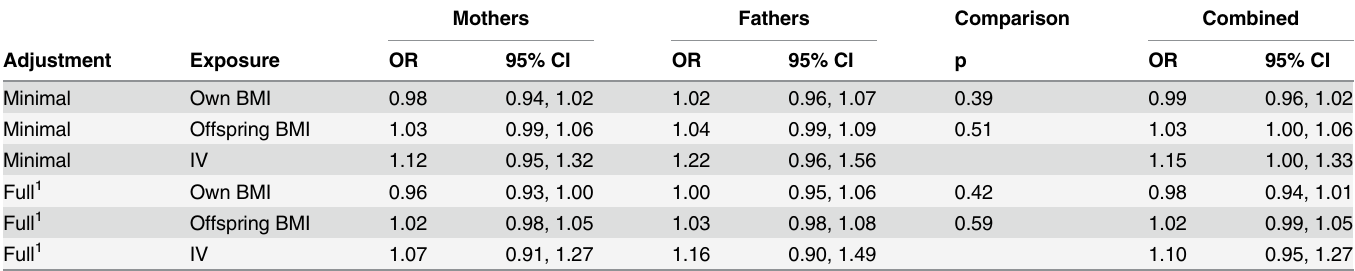
Table 4. Odds ratio for anxiety (HADA > = 8) per sex-specific SD of body mass index.